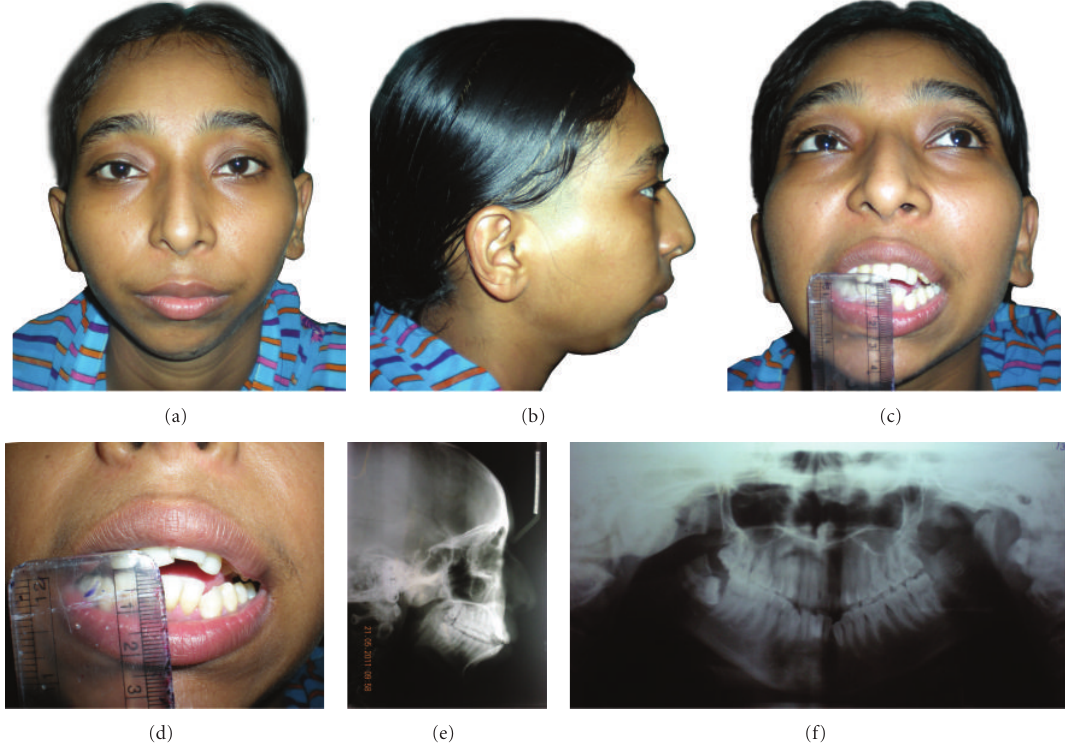
Figure 1: (a)–(f) pretreatment, before TMJ ankylosis surgery. Mouth opening restricted to 3mm only.